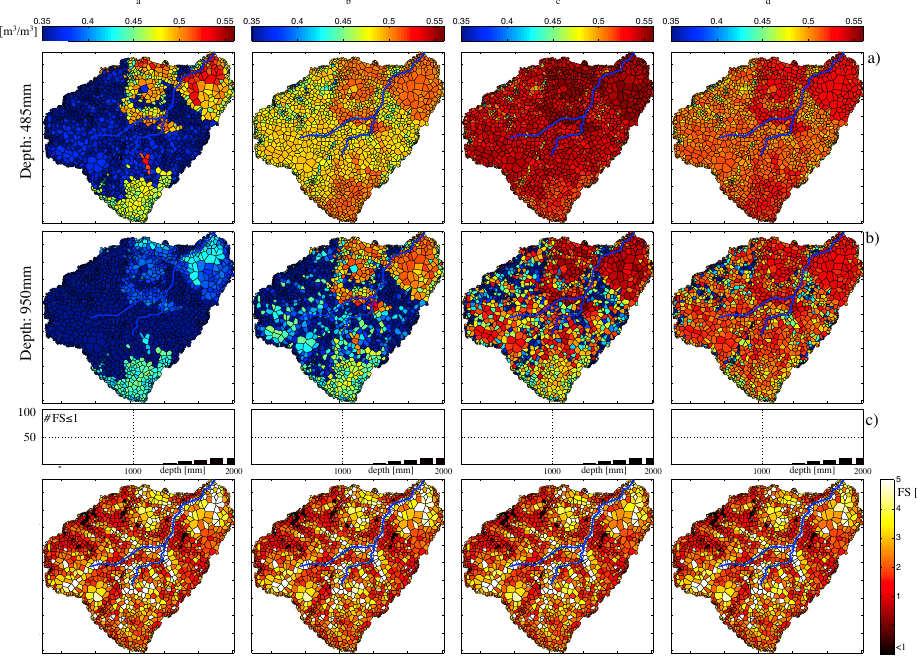
Fig. 8. Spatial distribution at selected time steps (from left to right: t a , t b , t c and t d ) for anisotropy equal to 300: soil moisture at depths 485mm (a) and 950mm (b) , and FS distribution obtained either as the minimum value along the vertical profile, for FS always larger than 1, or as the first depth where FS ≤ 1 (c)